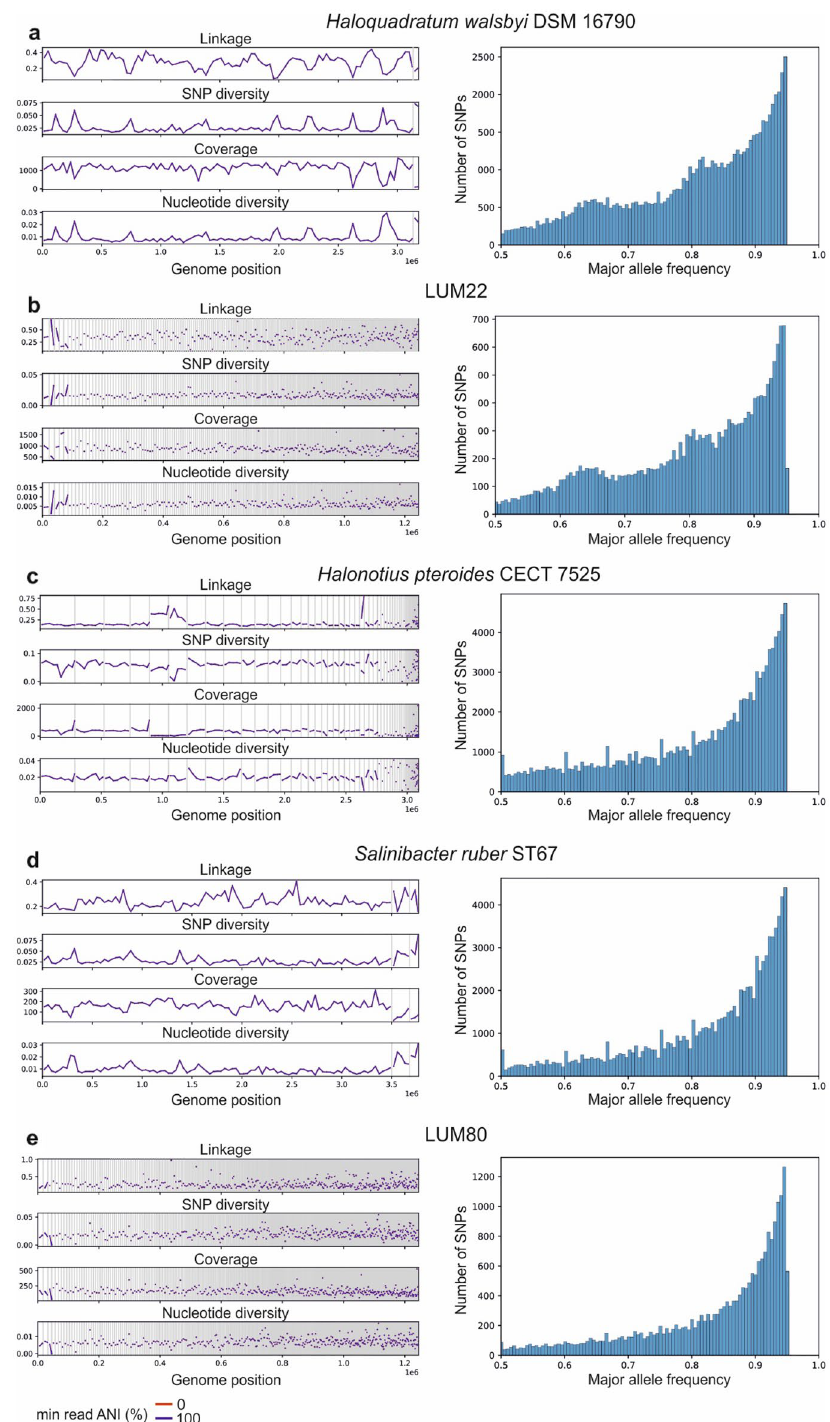
Figure 4. Genetic variation (SNP diversity, coverage, and nucleotide diversity) of Haloquadratum walsbyi DSM 16790 ( a ; left), LUM.22 ( b ; left), Halonotius pteroides CECT 7525 ( c ; left), Salinibacter ruber ST67 ( d ; left), LUM.80 ( e ; left). Distribution of major allele frequency of bi-allelic SNVs in Haloquadratum walsbyi DSM 16790 (~ 2500 SNVs with 95% major allele frequency) ( a ; right), LUM.22 (~ 700 SNVs with 95% major allele frequency) ( b ; right), Halonotius pteroides CECT 7525 (4000 SNVs with 95% major allele frequency) ( c ; right), Salinibacter ruber ST67 (~ 4000 SNVs with 95% major allele frequency) ( d ; right), LUM.80 (~ 1200 SNVs with 95% major allele frequency) ( e ;